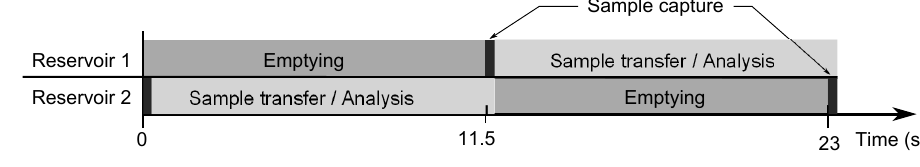
Fig. 4. The three steps of the MEDEE operating cycle (emptying, capture and analysis), for each of the two reservoirs.